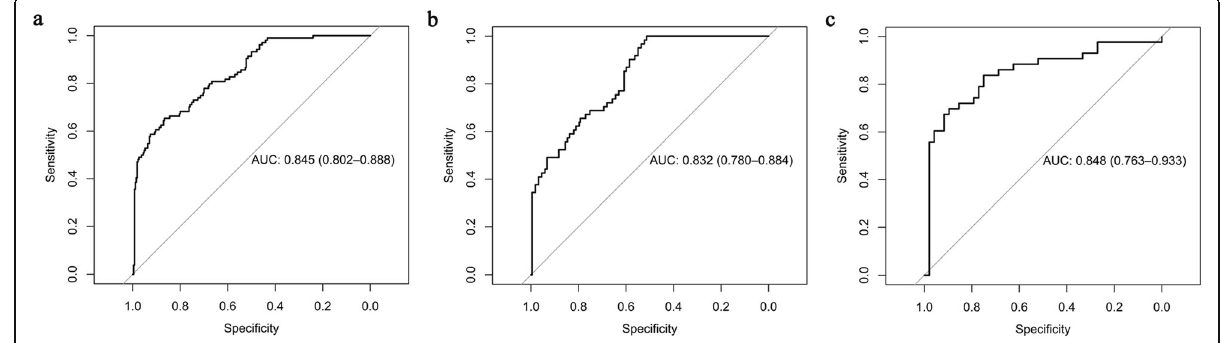
Fig. 3 Bootstrapping analysis of the ability of SUVmax to predict PD-L1 expression in overall NSCLC ( a ), AC ( b ), and SCC ( c